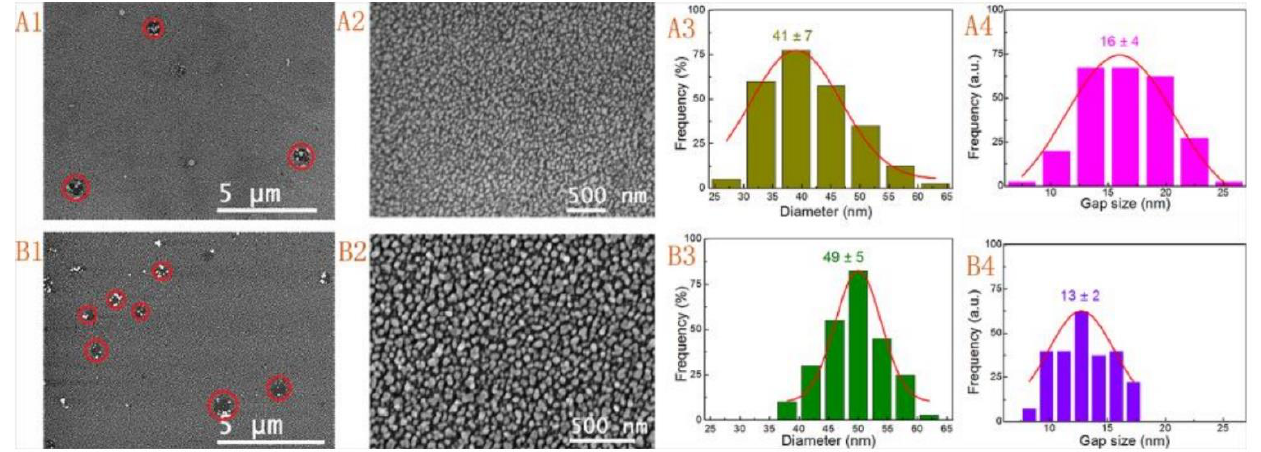
Figure 9. SEM images ( A1 , A2 , B1 , B2 ), size distributions ( A3 , B3 ), and gap size distributions ( A4 , B4 ) of Au NP films obtained by using seed I activation and with an immersion time of 30 min ( A1 – A4 ) and seed II activations with an immersion time of 12 h ( B1 – B4 ) [90].